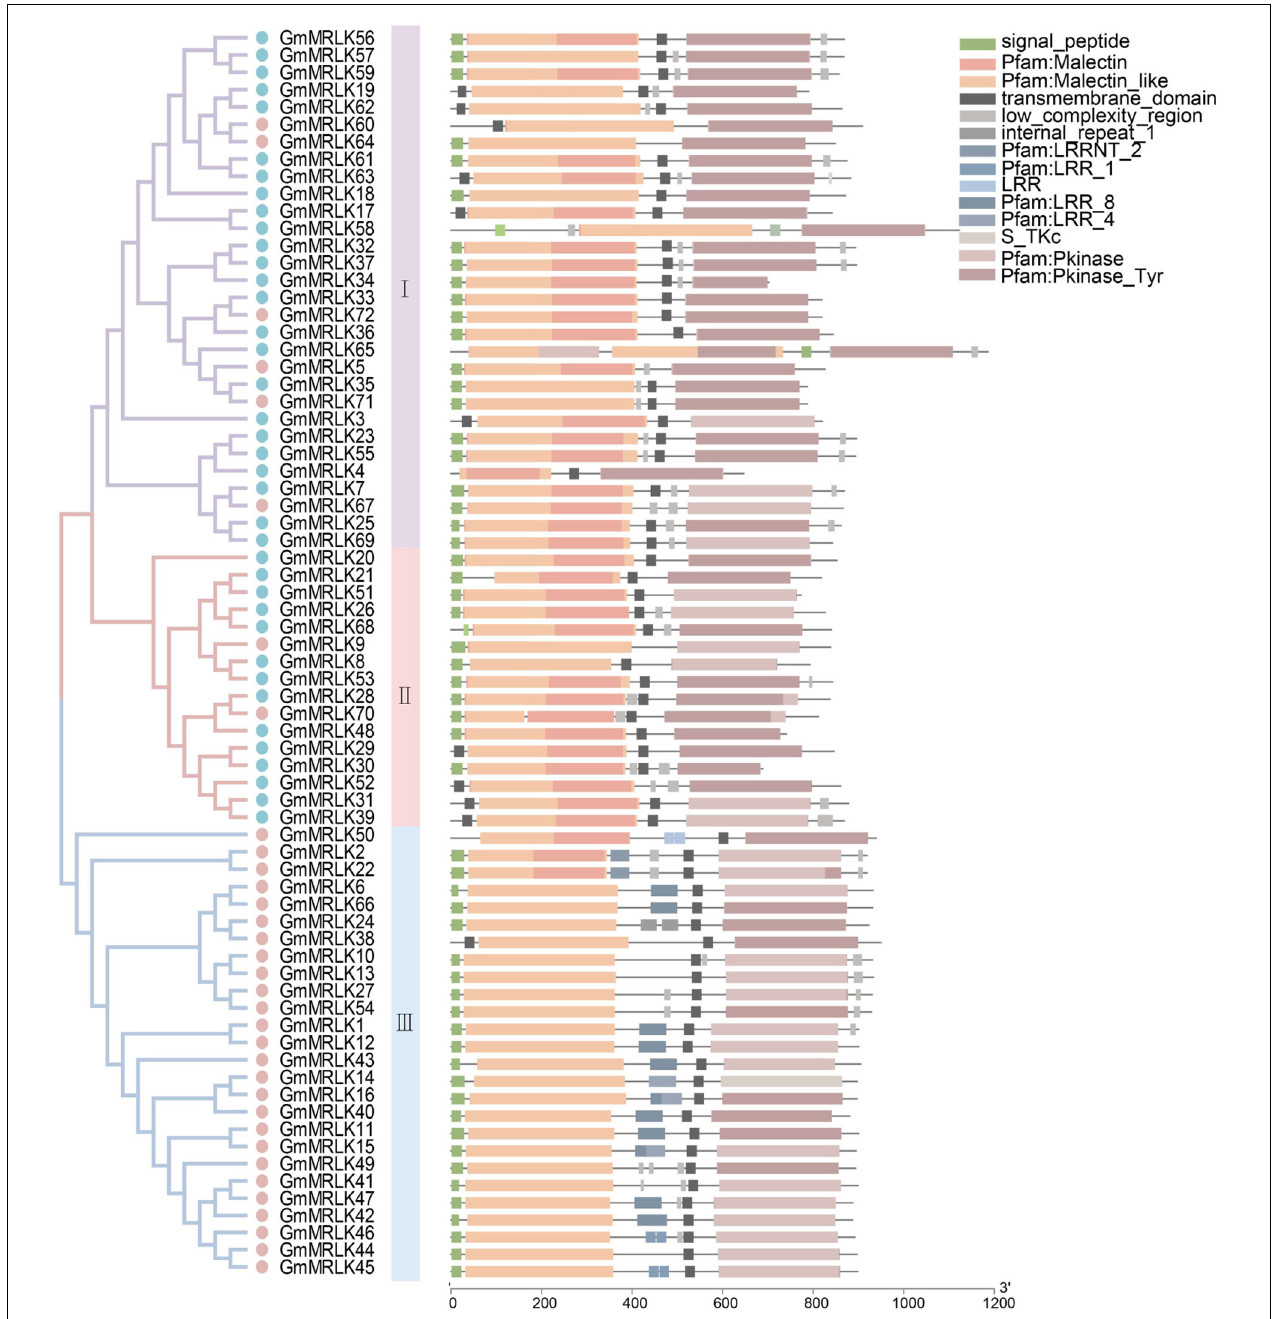
FIGURE 1 | Analyzation of malectin domain-containing receptor-like kinases (MRLKs) in soybean. Phylogenetic tree analysis of soybean MRLKs. The protein sequences of GmMRLKs were aligned by ClustalW. The three different subgroups are marked by shadows of purple, green, and orange colors. The CrRLK1L proteins were marked by blue dots and the remaining GmMRLKs were marked by pink dots. Domain structures of GmMRLKs. The motif composition of the GmMRLKs were analyzed by Batch SMART. Different motifs were represented by rectangles of different